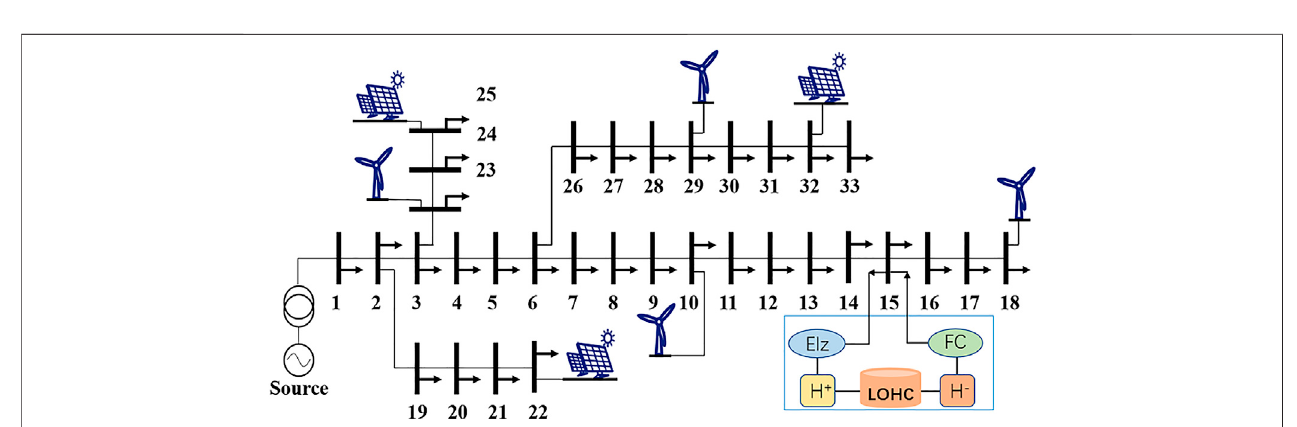
FIGURE 7 | IEEE 33-node EHCM distribution structure.